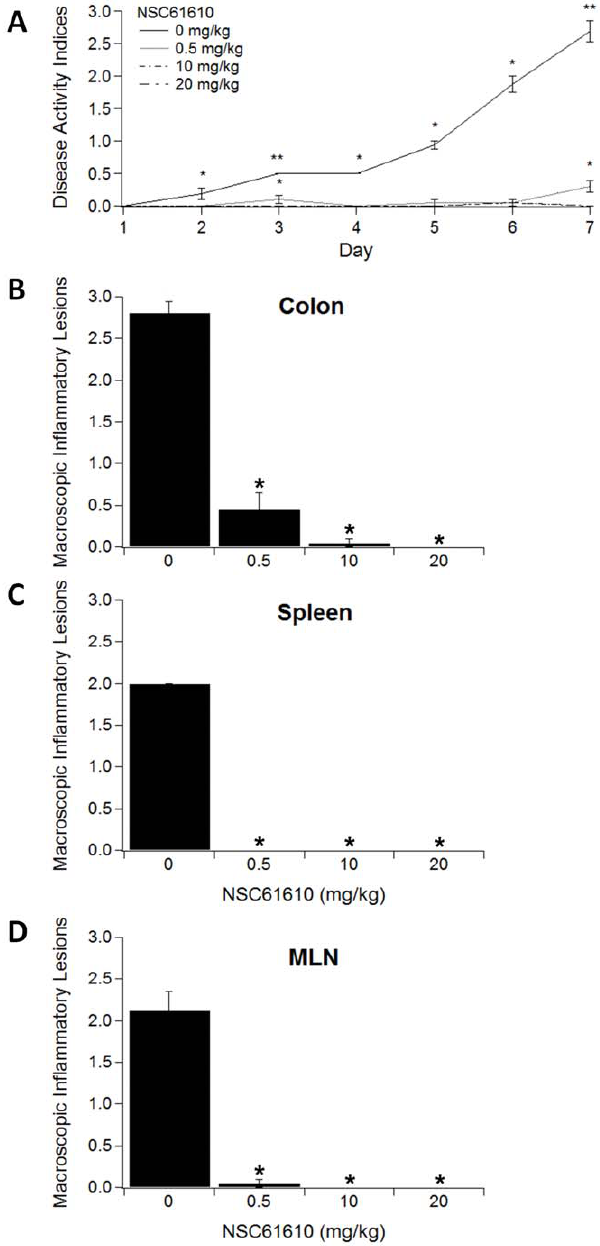
Figure 3. Oral treatment with NSC61610 ameliorates experi- mental inflammatory bowel disease. Mice were challenged with 2.5% dextran sodium sulfate in the drinking water for 7 days. Disease activity index (DAI), a composite score reflecting clinical signs of the disease (i.e. perianal soiling, rectal bleeding, diarrhea and piloerection), was assessed daily. Panel A illustrates the effect of NSC61610 on disease severity in mice with colitis. Panels B–D illustrate the effect of NSC61610 on macroscopic inflammatory lesions in the colon (B), spleen (C), and mesenteric lymph nodes (MLN) (D). Data are represented as mean 6 standard error (n=10). In figure A, data points with asterisks are significantly different from control and data points with two asterisks are significantly different from those with one asterisk ( P , 0.05 ). In figure B–D, bars with an asterisk indicate that a treatment is significantly different from its control ( P , 0.05